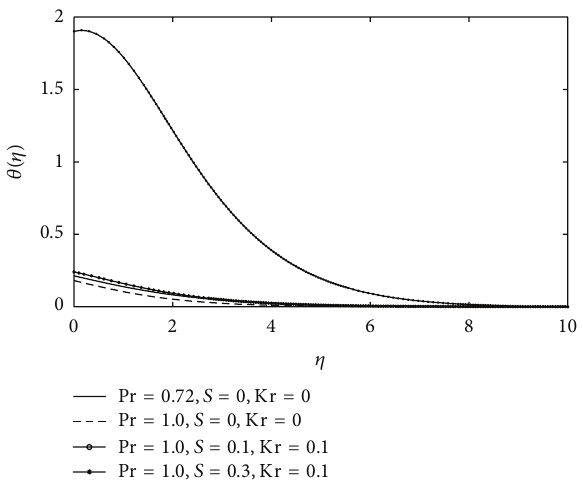
Figure 13: Temperature profiles for different values of Pr, 𝑆 , and Kr for Ha = 0.1 , Gr = 0.1 , Gc = 0.1 , Sc = 0.62 , Bi = 0.1 , and Nc = 0.01 .